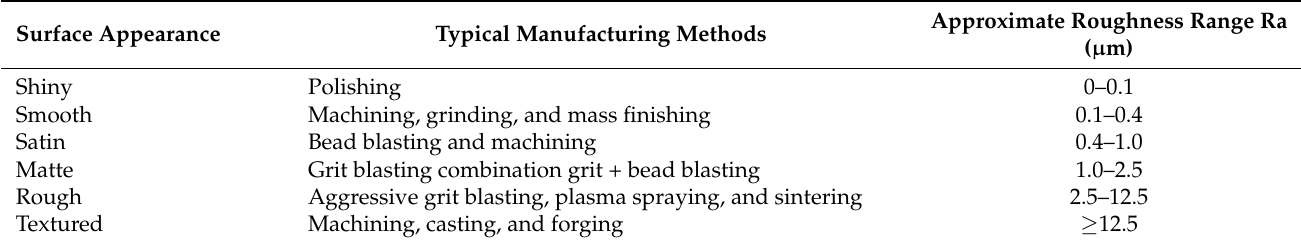
Table 5. Definitions of metal implant surface appearance and typical methods of